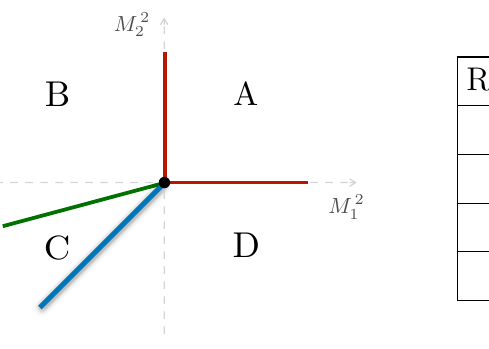
Figure 10 . Phase diagram of the bosonic theory in the case p double condensation coincides with C , including the blue line.